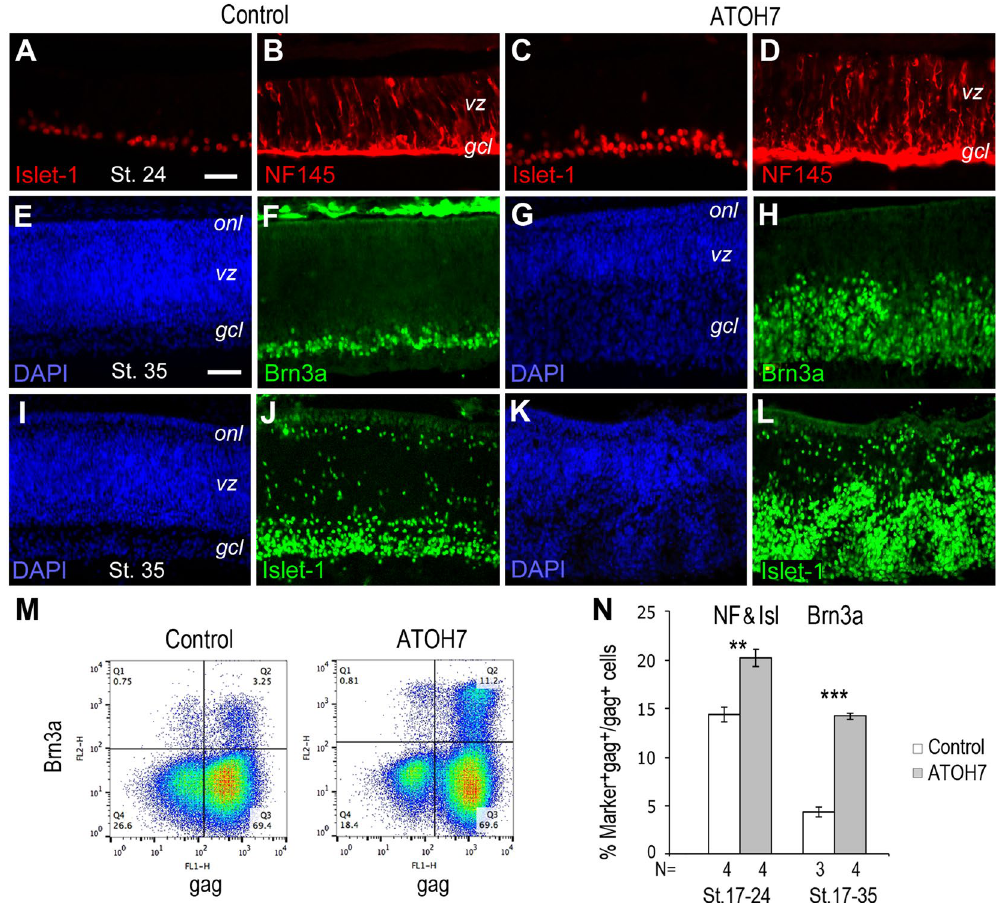
Figure 2. Influence of ATOH7 on retinal ganglion cell production. ( A – D ) Immunocytochemistry of retinas infected with the control ( A , B ) or ATOH7 virus ( C , D ) at stage 10 and labeled for Islet-1 ( A , C ) or NF145 ( B , D ) at stage 24. ( E – L ) Immunocytochemistry of retinas infected at stage 17 with the control ( E , F , I , J ) or ATOH7 virus ( G , H , K , L ) and labeled at stage 35 for Brn3a ( F , H ) or Islet-1 ( J , L ). The DAPI labeled panels ( E , G , I , K ) correspond to ( F , H , J , L ), respectively. Scale bars: A (for A – D ), E (for E – L )10 μ m. gcl , ganglion cell layer; onl , outer nuclear layer; vz , ventricular zone. ( M , N ) Flow cytometry quantification of RGC markers. ( M ) Representative flow cytometry profiles of retinas infect at stage 17 and labeled for Brn3a at stage 35. ( N ) Bar graph shows RGC marker-positive cells among gag-positive viral infected cells. Retinas infected at stage 17 were analyzed at stage 24 for NF145 and Islet-1 double positive cells, and at stage 35 for Brn3a. Numbers of independent samples analyzed and duration of viral infections are indicated below the bars. Error bars indicate SEM; ** p < 0.01, *** p <